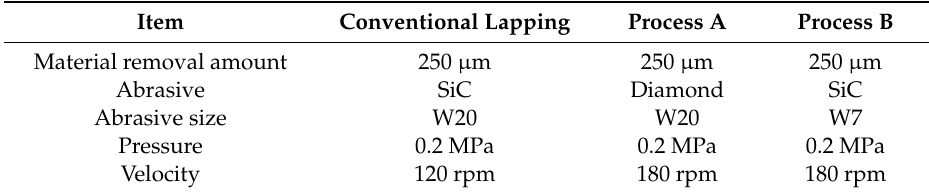
Table 1. Process parameters in the lapping